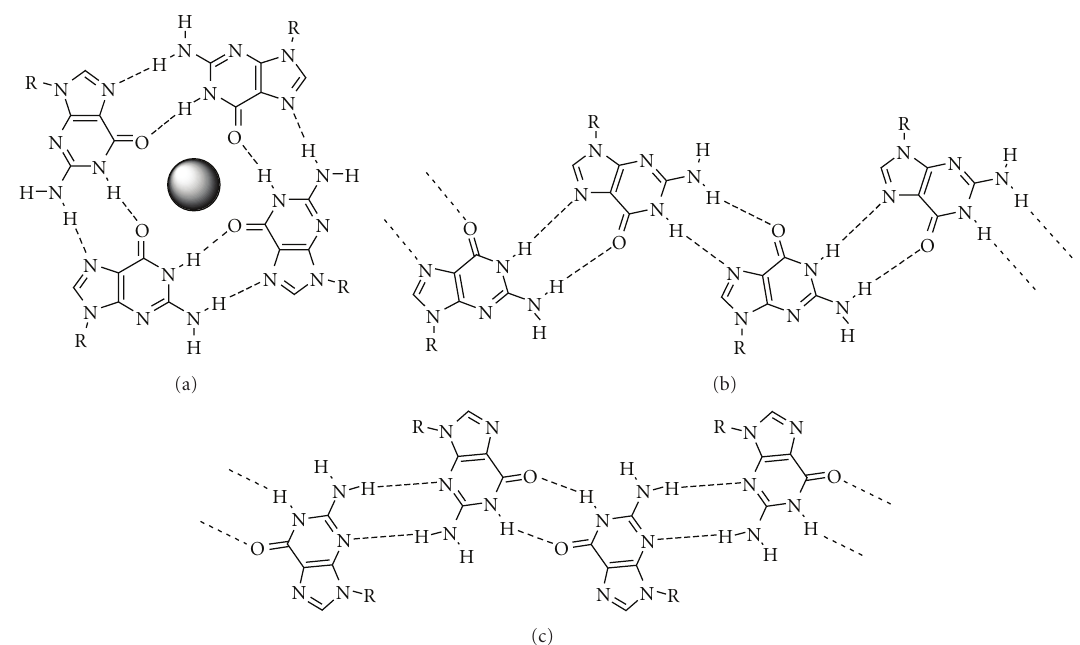
Figure 1: (a) G-quartet structure (the sphere indicates the central cation), (b) A-type ribbon, and (c) B-type ribbon.